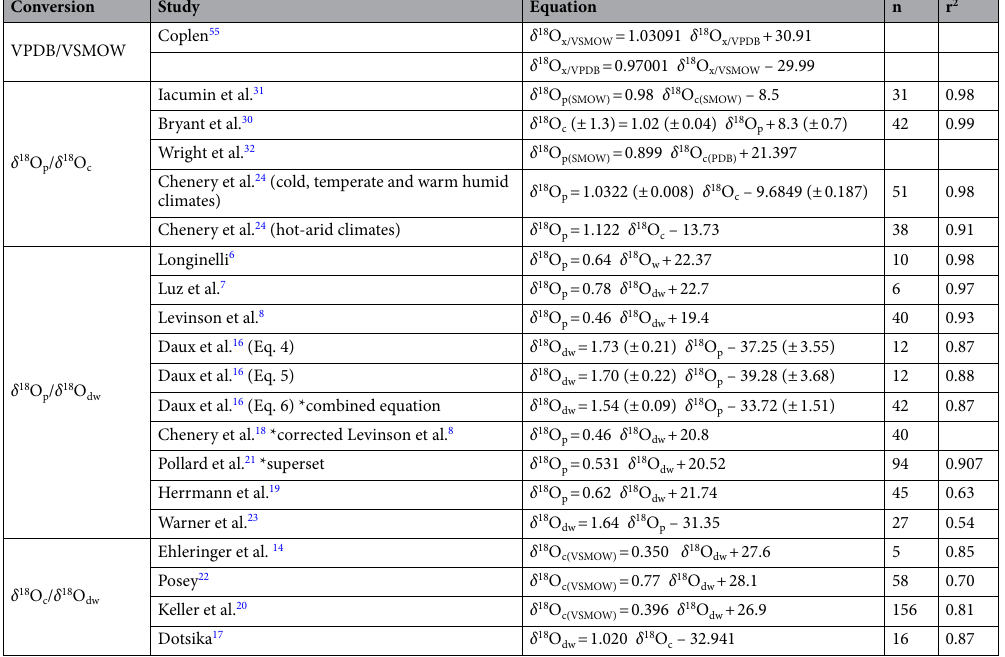
Table 3. Existing conversion equations.